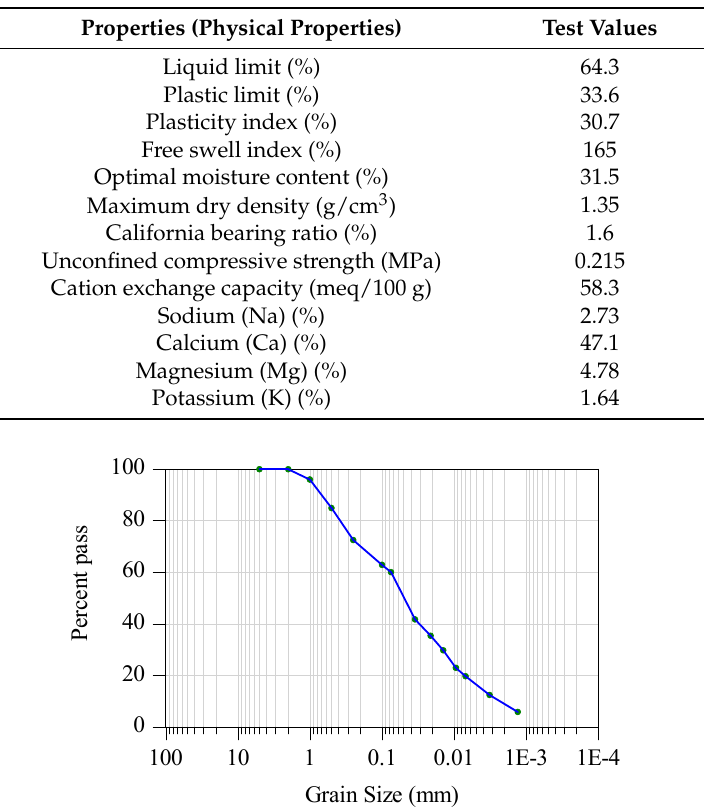
Table 1. Physical properties and cation exchange capacity (CEC) of BCS.